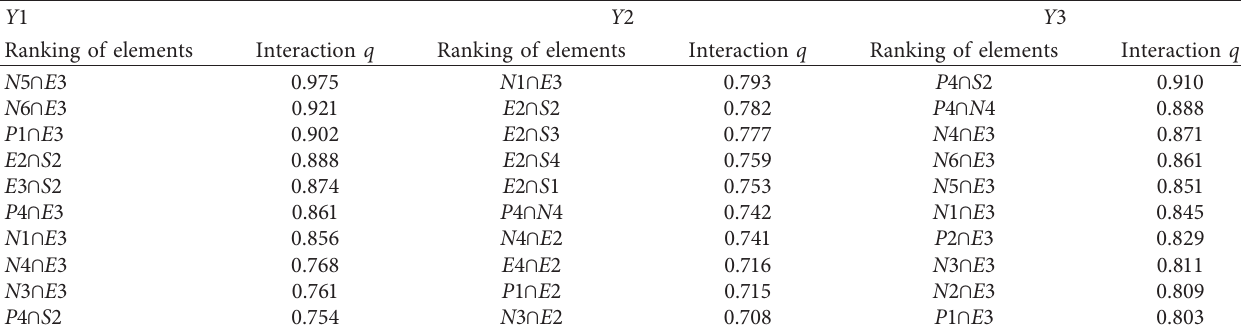
Table 9: Results of interaction detection of influential elements of urban resilience (top 10 by q